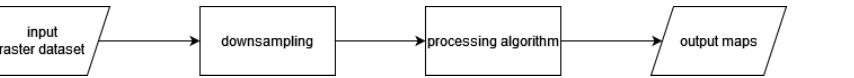
Figure 3. The treatment of the experiment, which resembles a typical remote sensing analysis workflow that requires